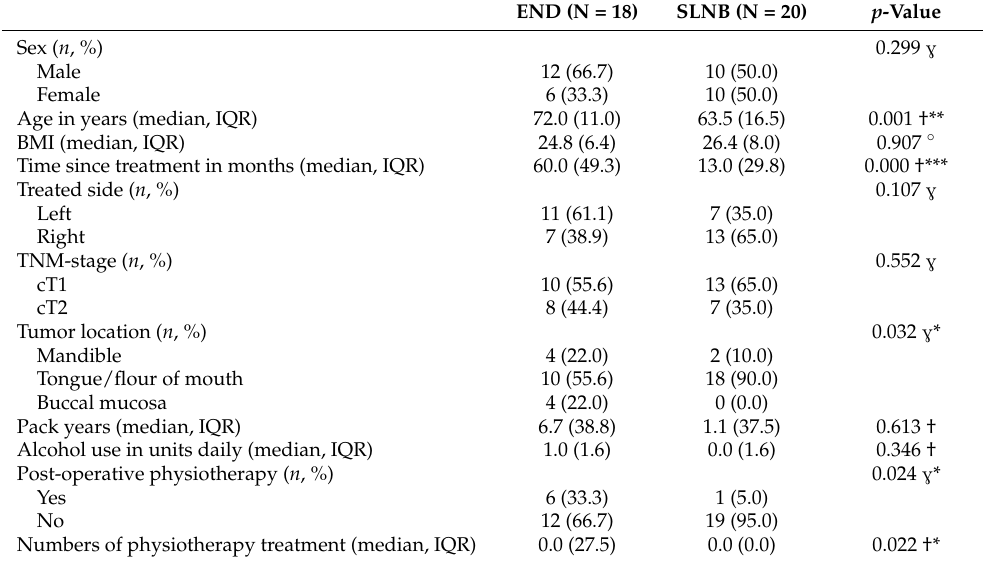
Table 1. Demographic and clinical